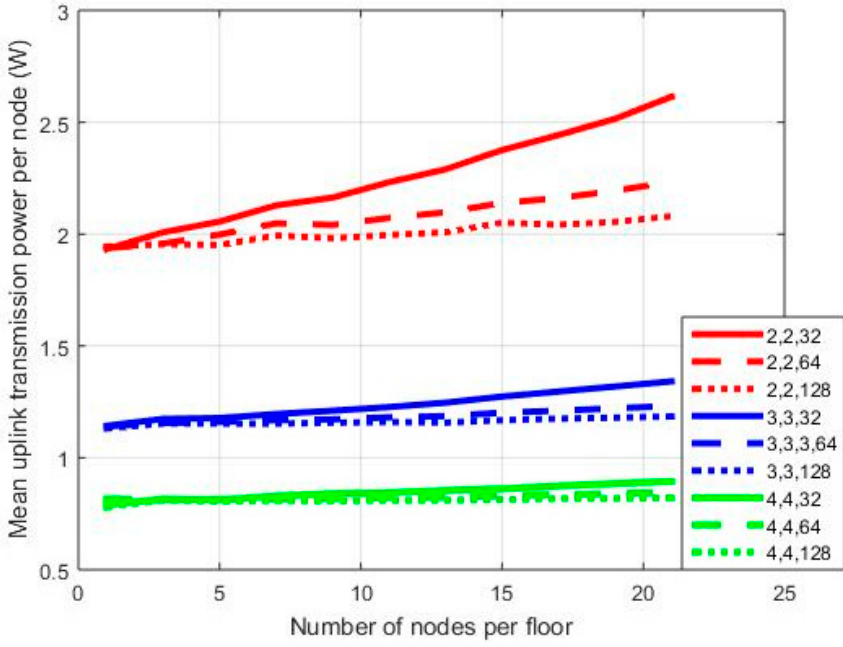
Figure 3 . Mean power per node for SNR = 3 dB.